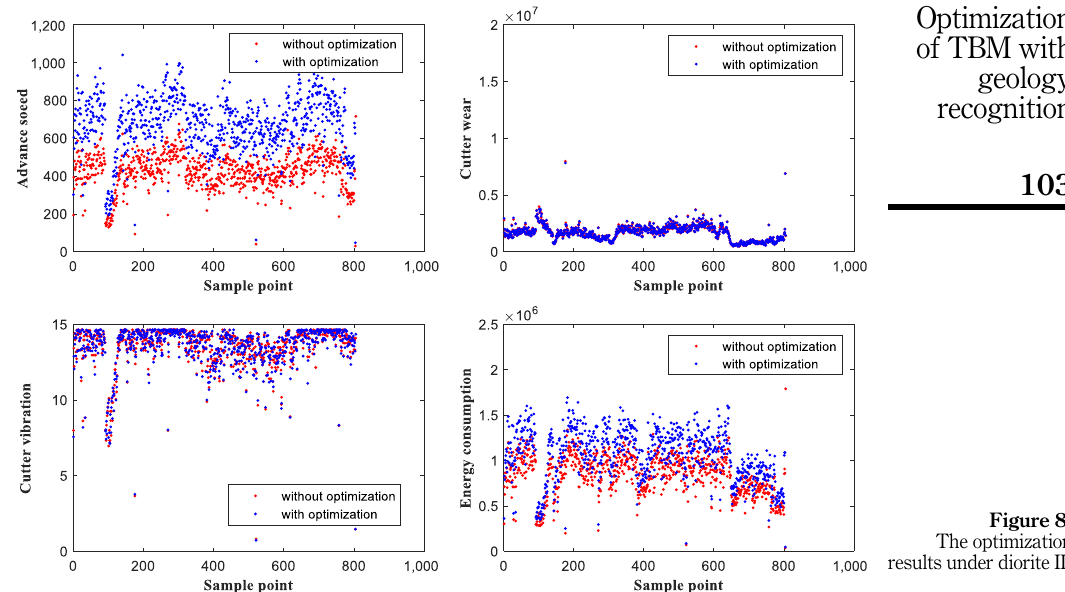
Figure 8. The optimization results under diorite